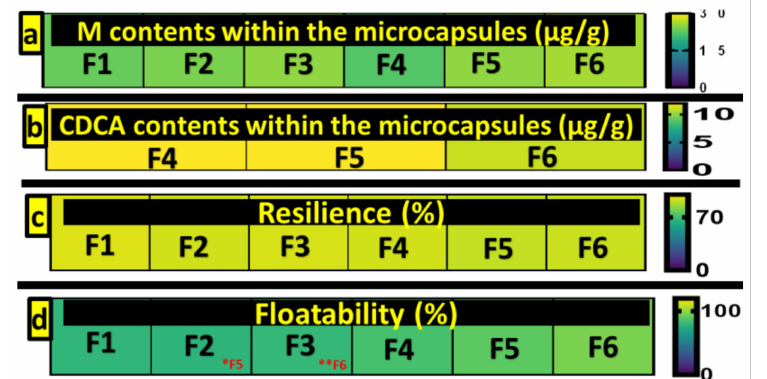
Figure 2. Metformin contents of microcapsules ( a ), CDCA contents of microcapsules ( b ), mechanical resistance of microcapsules ( c ) and buoyancy of microcapsules ( d